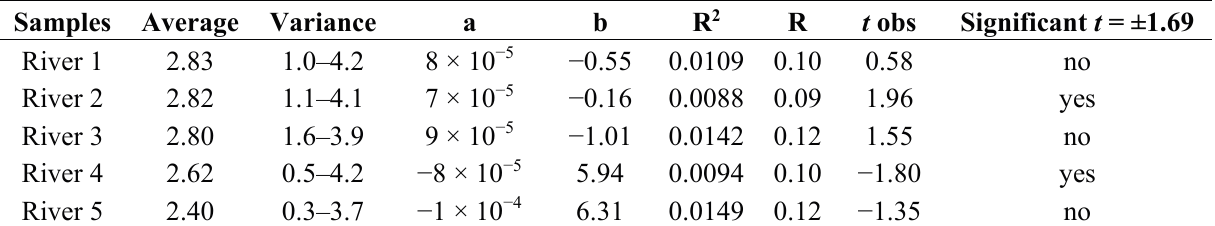
Figure 3. ( a ) daily rainfall (mm) and fecal coliforms (log 10 cfu/100 mL) in municipal samples from 2006 and ( b ) daily rainfall and fecal coliforms or E. coli (log 10 cfu/100 mL) from 2012. Table 2. Average and variance of fecal bacterial concentrations (log 10 cfu/100 mL) in river samples 1 to 5 with linear regression analysis (Y = ax + b) and result of null hypothesis based on t -distribution (37 samples analyzed for each river sampling